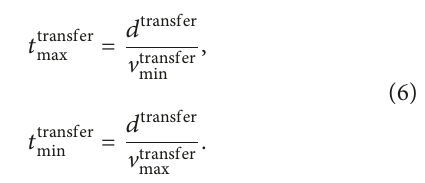
on Table 1, the StB of down direction during 8:00 AM